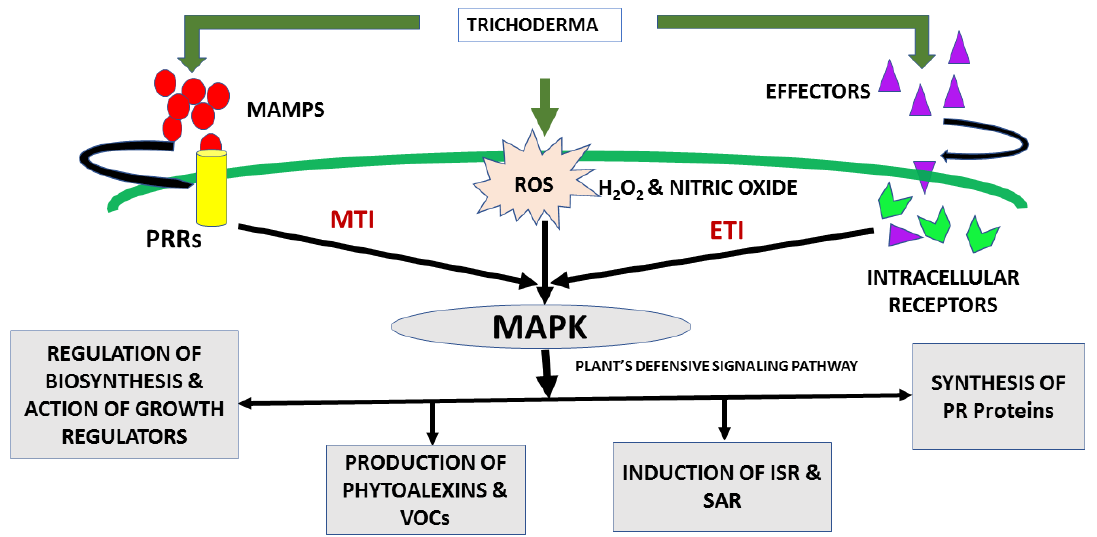
Figure 4. Plant- Trichoderma interaction involves the recognition molecules, i.e., MAMPS (microbe- associated molecular patterns) and effectors. MAMPS and effector molecules bind to the PRRs (pattern recognition receptors) and intracellular receptors and thereby initiate the MTI (MAMPS triggered) and ETI (effector triggered) immunity in plants, respectively. Moreover, this interaction also leads to the production of ROS (reactive oxygen species), which serve as signaling molecules and initiate a defensive response in plants by synthesis of antifungal molecules like phytoalexins, VOCs (volatile organic compounds), PRs (pathogenesis related) proteins such as CWDEs, etc. Trichoderma also improved the plant growth in pathogen-contaminated soil by regulating the expression of genes involved in growth regulation as well as induction of disease resistance.